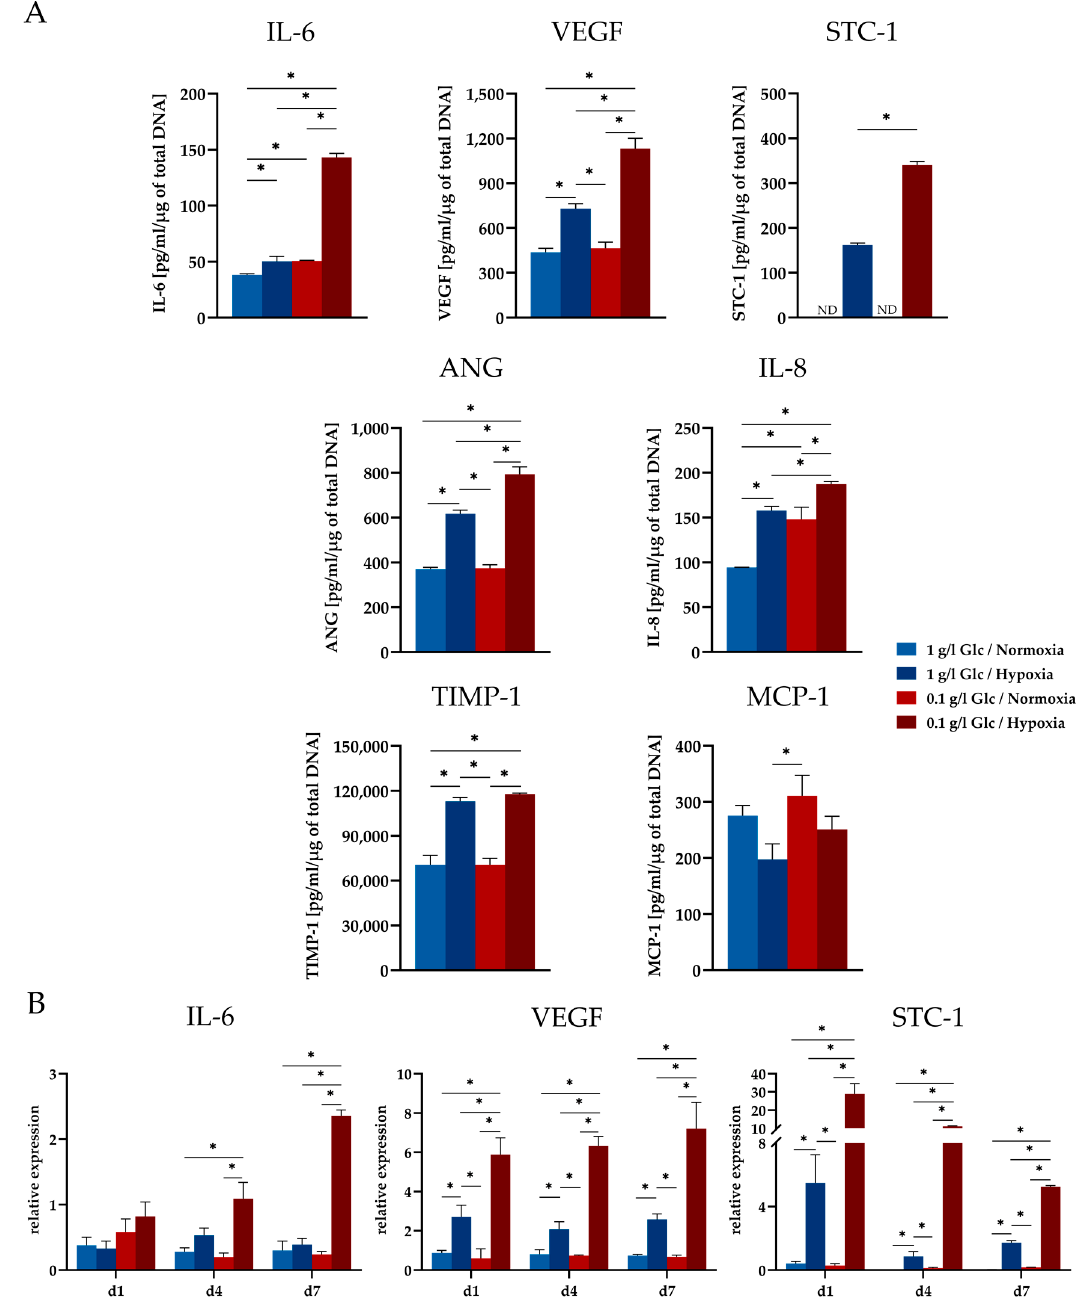
Figure 5. Expression of cytokines in ASCs under deprivation conditions. ( A ) Enzyme-linked immunosorbent assays for IL-6, VEGF, STC-1, ANG, IL-8, TIMP-1, and MCP-1 in the supernatant medium of ASCs cultured under normoxia (21% O 2 ) or hypoxia (0.2% O 2 ) with either 1 or 0.1 g / L glucose at day 4 of culture; the obtained values were normalized to the DNA content of the respective samples. ( B ) Corresponding gene expression of IL-6, VEGF, and STC-1. Gene expression was normalized to EF1 α ; the obtained values were further normalized to day 0. (Note: Day 0 values are the same for all groups.) Data are presented as means ± SD of n = 3; * p < 0.05. Abbreviations: IL-6: Interleukin-6; VEGF: Vascular endothelial growth factor; STC-1: Stanniocalcin-1; ANG: Angiogenin; IL-8: Interleukin-8; TIMP-1: TIMP metallopeptidase inhibitor 1; MCP-1: Monocyte chemoattractant protein-1; ND: Not detectable.